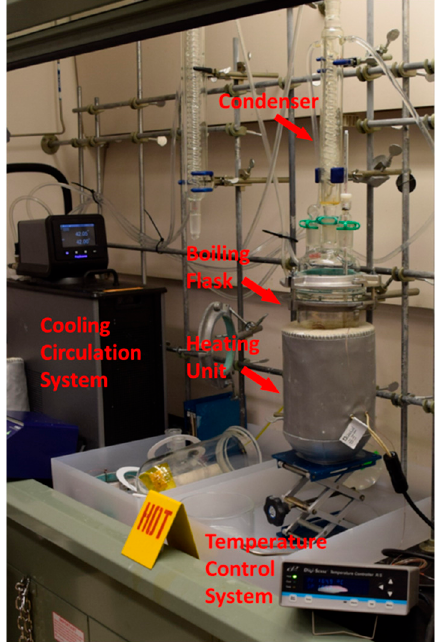
Figure 3. Boiling magnesium chloride test setup [50]. Reprinted/adapted with permission from Reference [50].